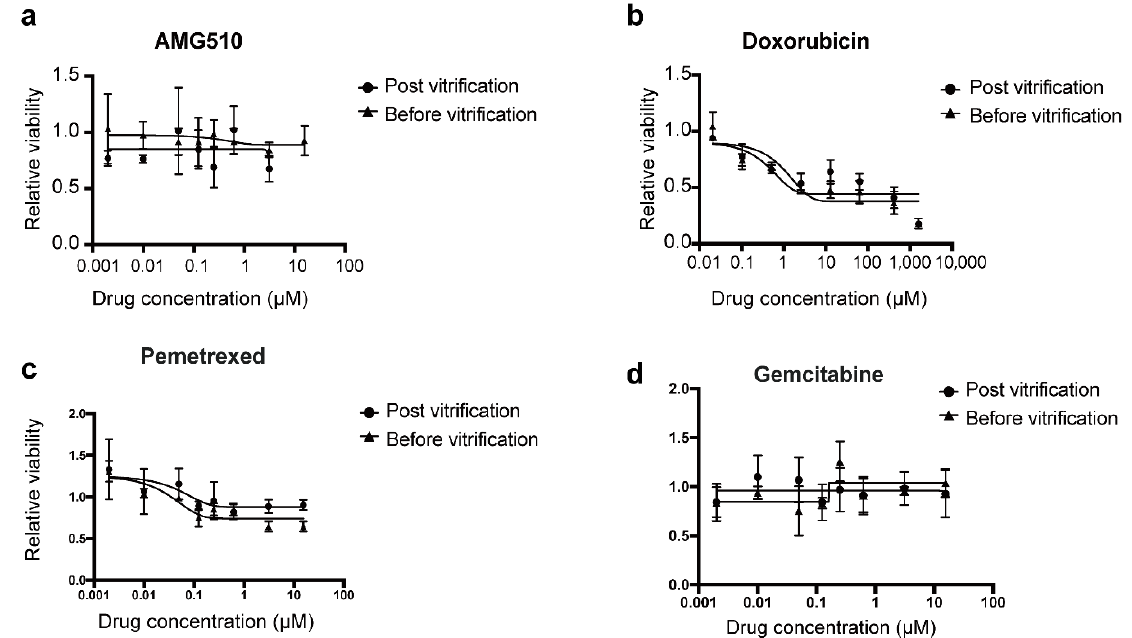
Figure 6. Drug sensitivity of the LCOs before and after the on-chip vitrification–thawing cycle. Drug response curves of AMG510 ( a ), doxorubicin ( b ), pemetrexed ( c ), and gemcitabine ( d ) are shown.